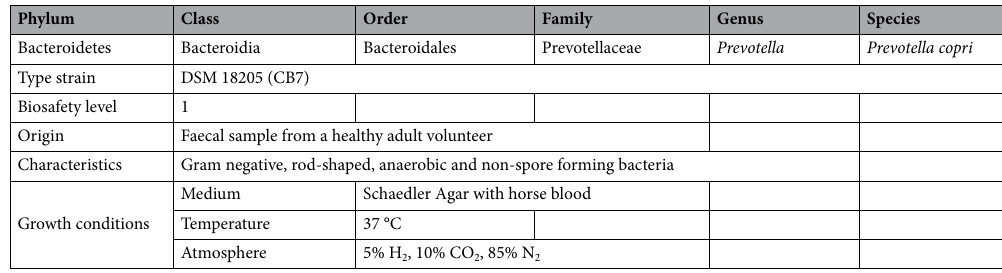
Table 1. General characteristics of P. copri.